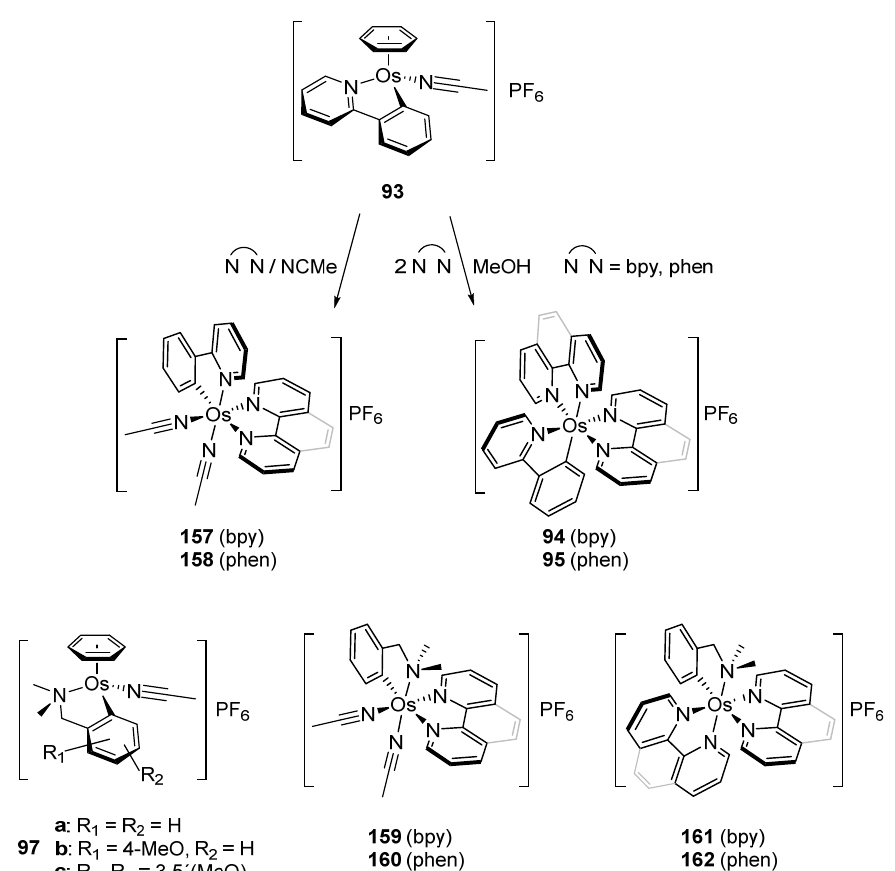
Figure 34. Synthetic routes to octahedral cyclometalated derivatives by ligand substitution starting from piano-stool complex 93 .